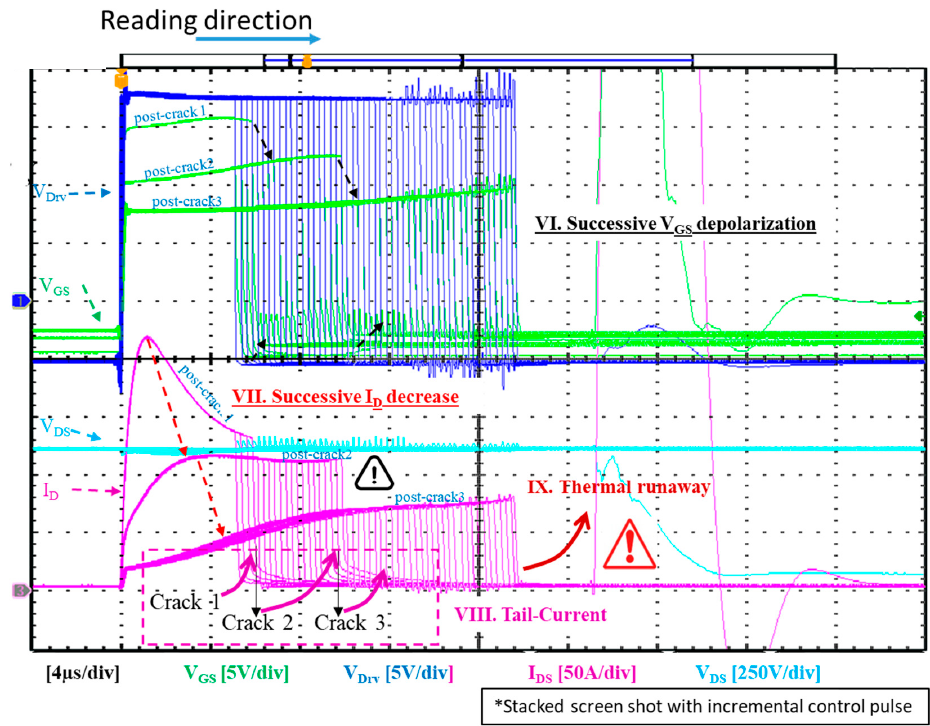
Figure 7. Stacked incremental pulse duration oscilloscope waveforms from 5.25 µs to 17.75 µs with a